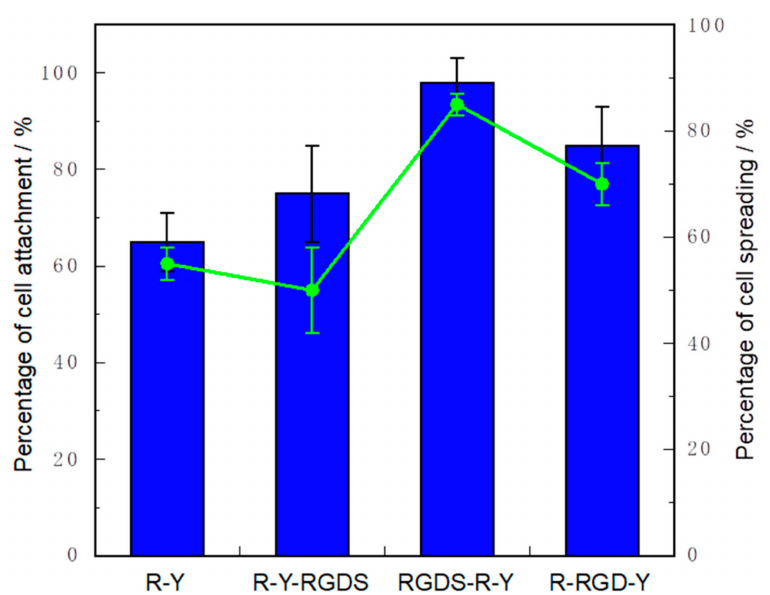
Figure 4. Result of cell attachment and cell spreading activity of R-Y derivative peptide modified onto cell culture plate. Incubation time; 6 h. * p < 0.05 vs R-Y, R-Y-RGDS. Blue: Cell attachment, Green line Cell spreading. Cell attachment test was carried out 1.0 × 10 4 cells/well (3.0 × 10 4 cells/cm 2 ) cells in each well ( n = 5) (Incubation time: